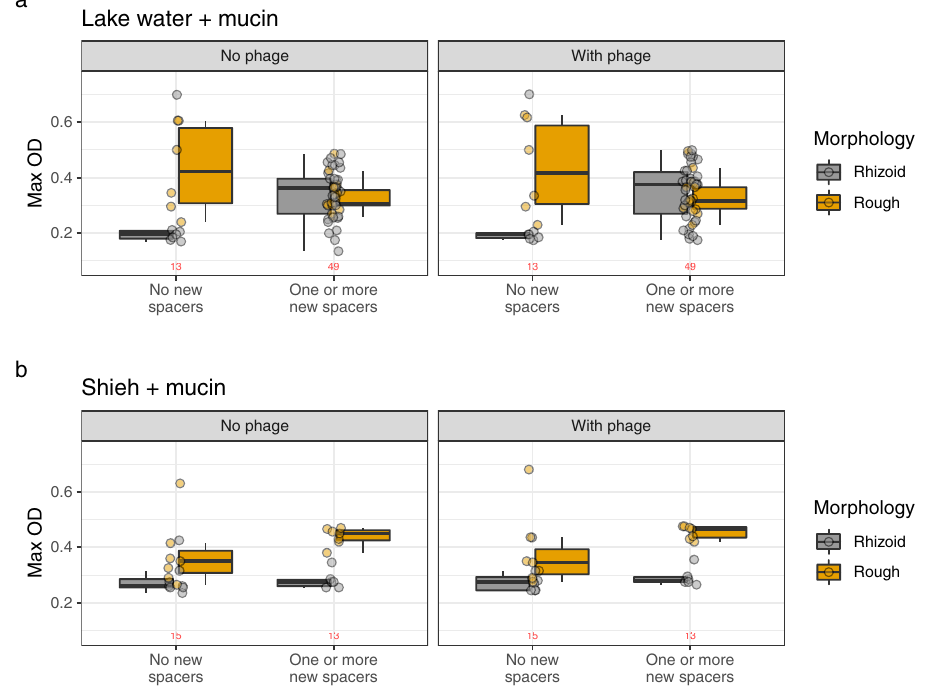
Fig. 5 The effect of spacers and morphotype in LW + M and Shieh + M isolates on bacterial growth. Isolates are grouped into having no new spacers or having one or more new spacers regardless of the CRISPR-Cas locus. Dots represent individual observations. The box plots capture the minimum and maximum values, 25th and 75th percentile (box) and the median (black horizontal line). The number of observations is shown in red for each dataset. a Isolates from Lake water + mucin treatments. b Isolates from Shieh + mucin treatments. Source data are provided as a Source Data fi